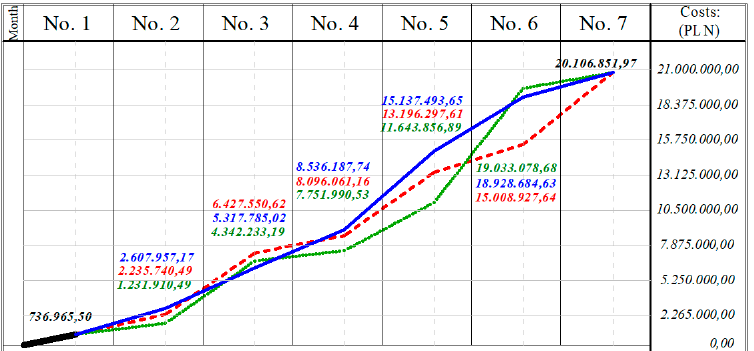
Figure 3. Cumulative values of planned costs (BCWS) of schedules-in implementation methods according to steady (dot chart), parallel (continuous chart), sequence (intermittent chart) execution of works. Source: [19].